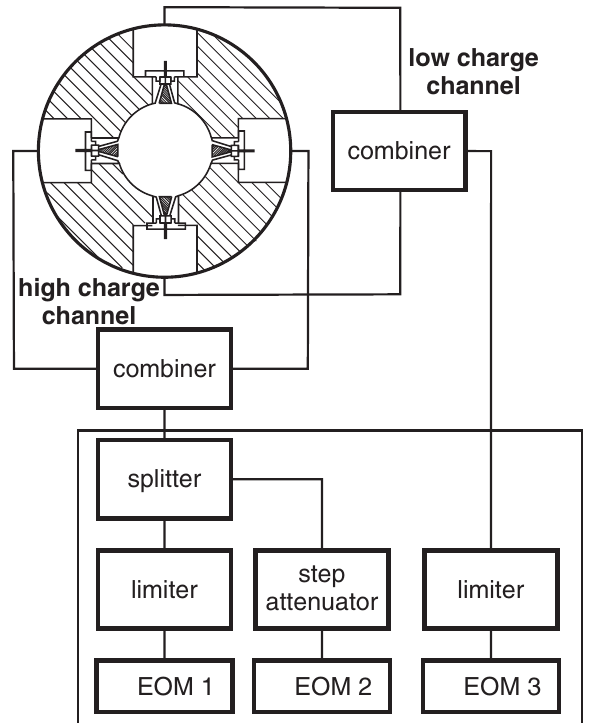
FIG. 9. Proposed rf cabling diagram for low and high charge operation mode of the bunch arrival-time monitor